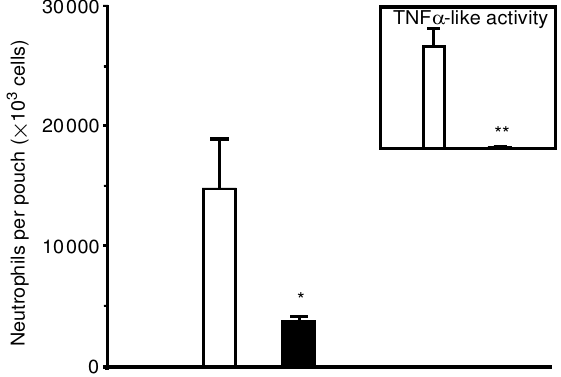
FIG. 8. Effects of the mouse polyclonal anti-TNF a antibody with neutrophil recruitment and TNF a -like induced by LPS. Results are expressed as mean SEM of total number of neutrophils per pouch and of TNF a -like activity concentra- tions recovered in the air pouch washing supernatants. The treated group received into their pouch 0.7 ml of the polyclonal antibody for 0.5 h, then LPS ( h ). The control group was treated with a non-immune antibody preparation under same conditions ( j ). Results are expressed as mean SEM of total number of cells for four experiments for the recruitment and of the TNF- a like activity (inset) recovered in the air pouch washing supernatants for four experiments. Comparison was performed for treated group ( j ) vs. control group ( h ) ( P , 0.05, P ,